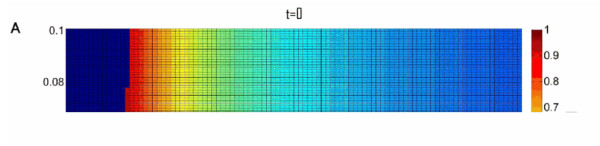
Phase diagrams depicting the evolutionary fate of the Z allele, in color scale (Right), as a function of its homing ability and toxicity. The colors correspond to the average Z frequency in the last 104 of 106 generations, u = 10-4 and v = 10-6 for all subfigures. A is for t = 0, B t = 0.1 s, and C t = s. When our deterministic simulations reached equilibrium we tested the asymptotic stability of that equilibrium by evaluating the eigenvalues of the Jacobian matrix at that point. The black line separates parameter values allowing for stable equilibria (bottom) from parameter values leading to no equilibria or non stable equilibria.